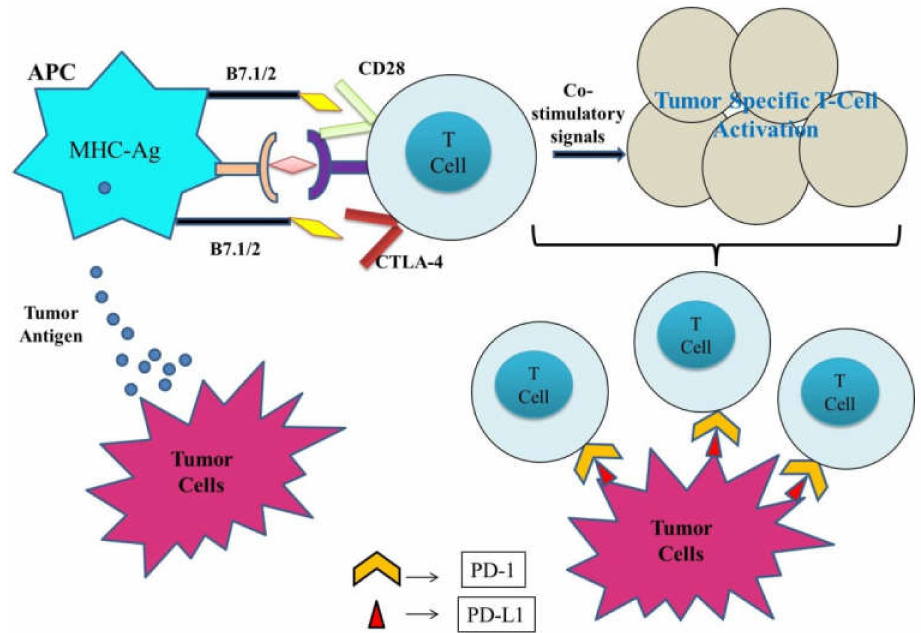
Figure 1. An overview of the correlation of several immune checkpoints with cancer initiation, progression, and